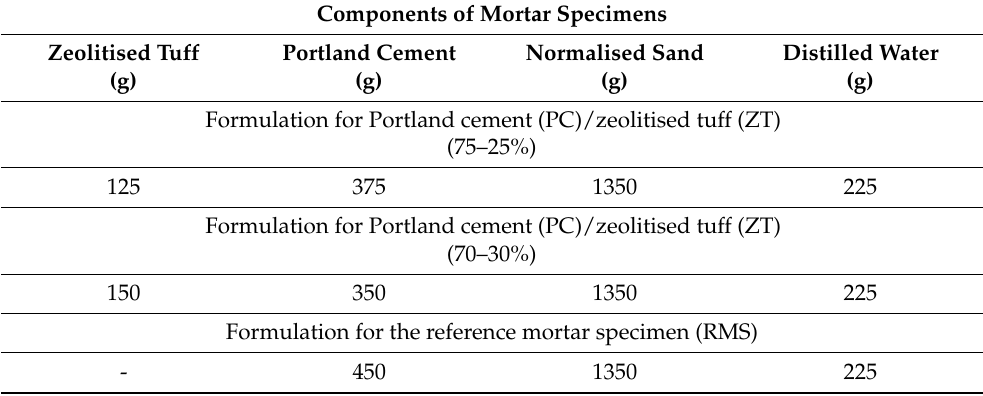
Table 2. Dosage project of mixed mortars and reference mortars specifying the proportions in all